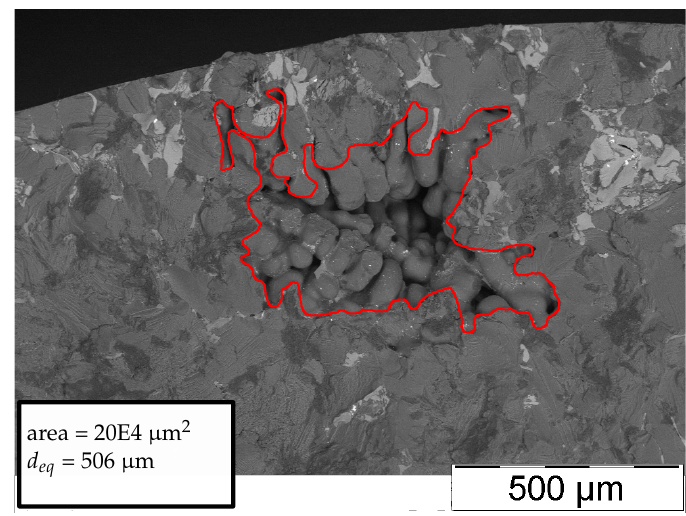
Figure 11. Representative fatigue fracture-initiating pore of position B.